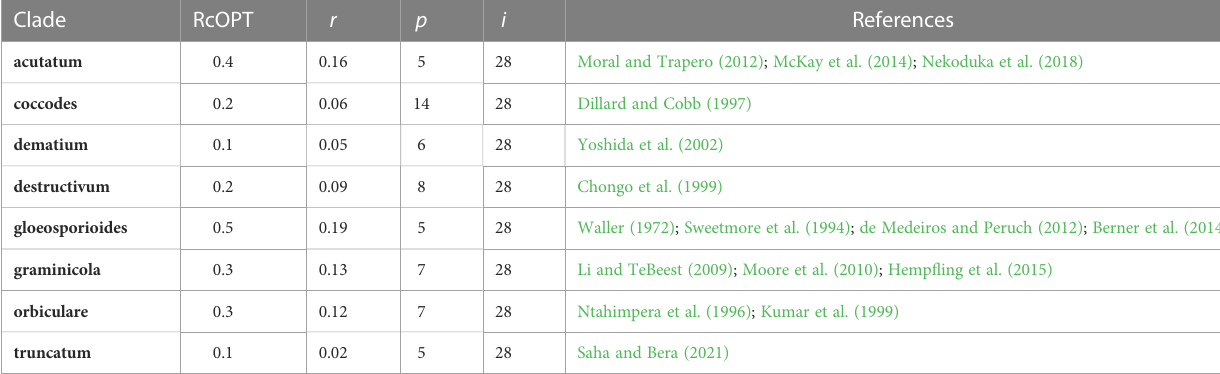
TABLE 3 Estimates of the optimum corrected basic infection rate (RcOPT) for eight Colletotrichum clades, latency period under favorable conditions for epidemics ( p ), infectious period under favorable conditions for epidemics ( i ), and publications reporting disease progress curves on a susceptible host variety used to calculate the apparent infection rate ( r